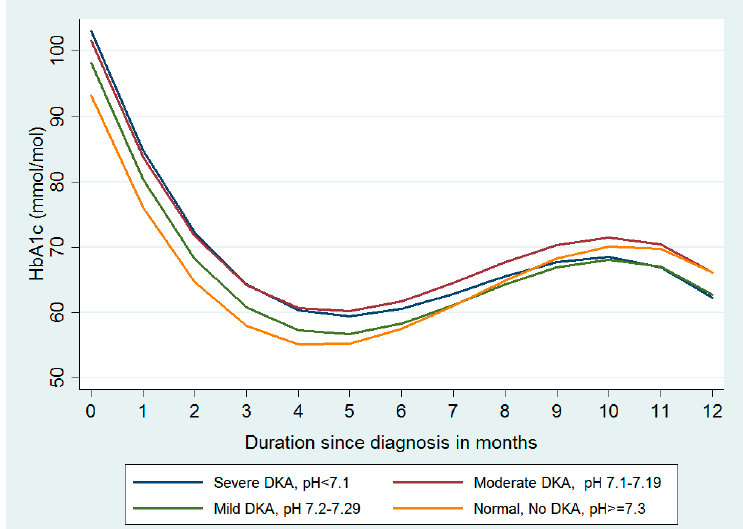
Figure 1. Linear adjusted and predicted HbA1 c trajectories based on DKA status at diagnosis in 364 children and young people diagnosed with type 1 diabetes and attending paediatric diabetes clinics in East London. DKA: diabetic ketoacidosis.